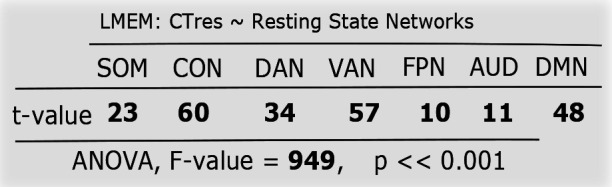
Distribution of location independent CT (CTres) among resting state networks.Similar to Figure 4—figure supplement 1, LMEM was performend on CT values, and found a significant difference between network. This result turns out that the significant impact of networks on CT is independent of location.